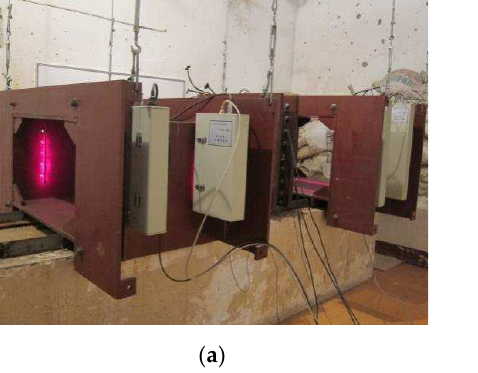
Figure 2. Test equipment and recording devices. ( a ) Laser velocimeter; ( b ) high-speed camera, pressure sensor and target-net velocimeter.